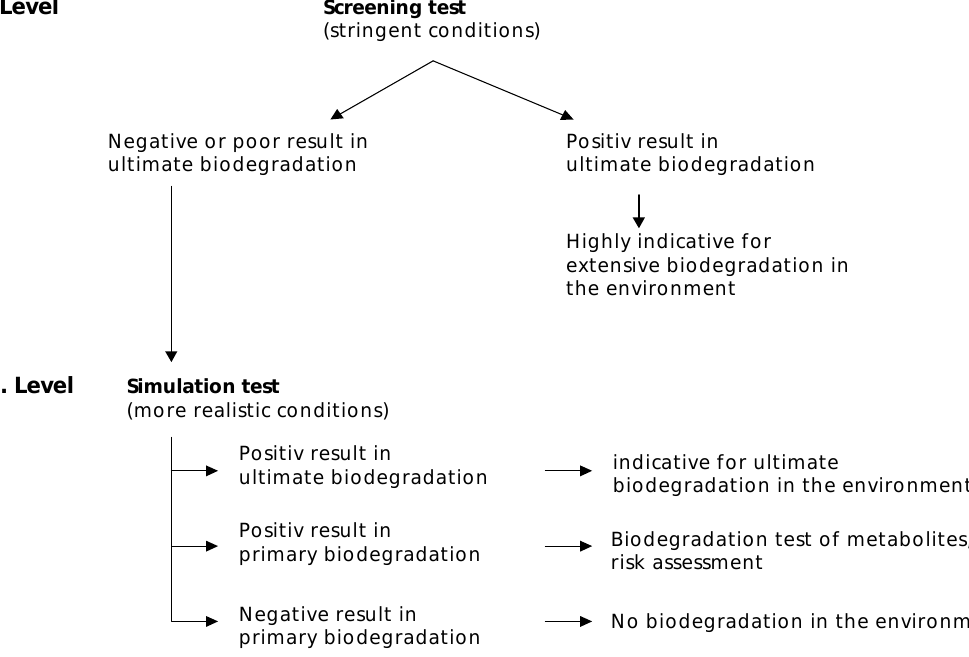
Figure 4 . Feature of testing biodegradation (aerobic or anaerobic) [10]. Screening test (stringent conditions)